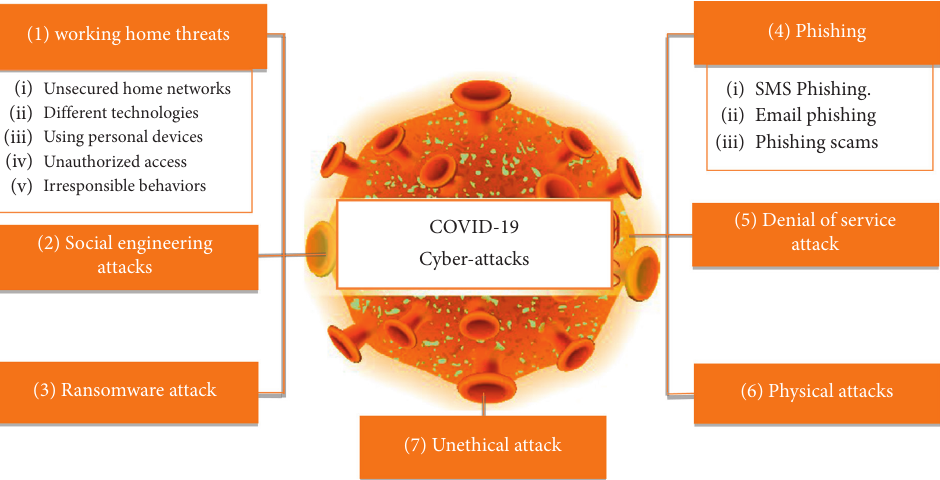
Figure 5: COVID-19 malicious cyberattacks.